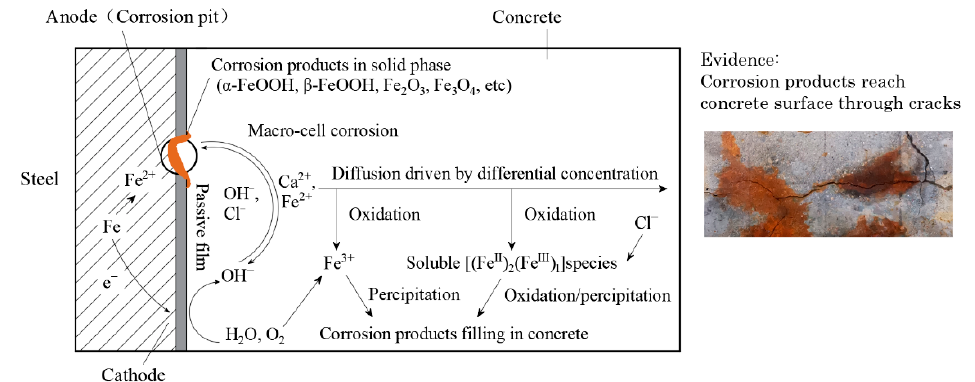
Figure 2. Mechanisms of the formation and transport of corrosion products. Table 1. Type and properties of corrosion products in reinforced concrete structures.